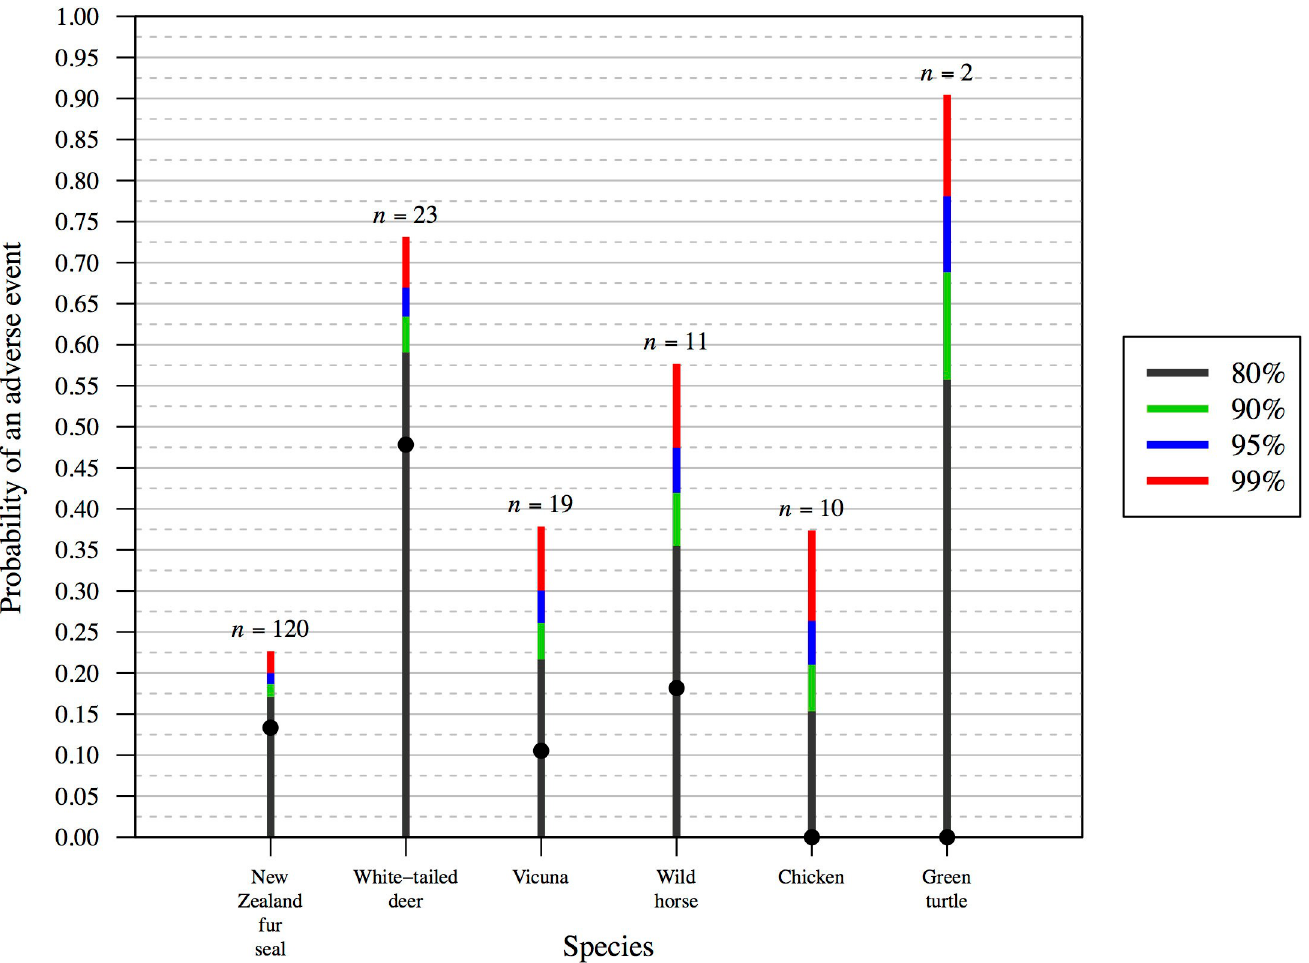
Fig 4. One-sided confidence interval estimates for adverse animal welfare event frequency estimates from six published research trials. Point estimates are shown (grey dots), as are the following confidence intervals: 80% (grey), 90% (green), 95% (blue) and 99% (red). It is evident that for studies that used small sample sizes, the confidence intervals are wide. For study details, see Table